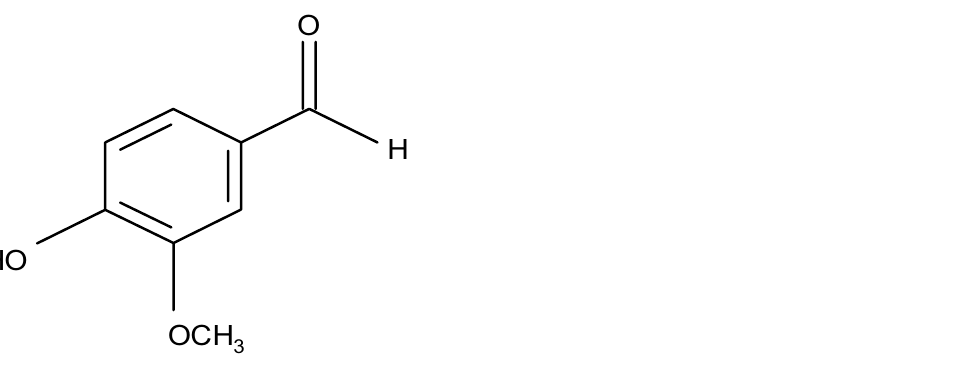
Figure 1. Chemical structure of